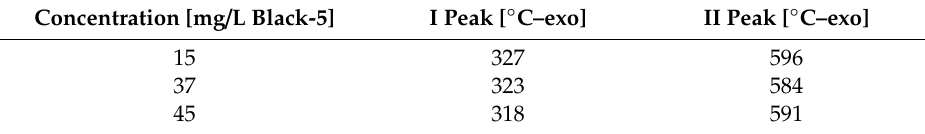
Figure 12. ( a ) DTA curves of purified MWCNTs after adsorption of the different solutions; ( b ) first exothermal DTA peaks. Table 3. Exothermic DTA peaks of purified MWCNTs for di ff erent concentrations. Concentration [mg / L